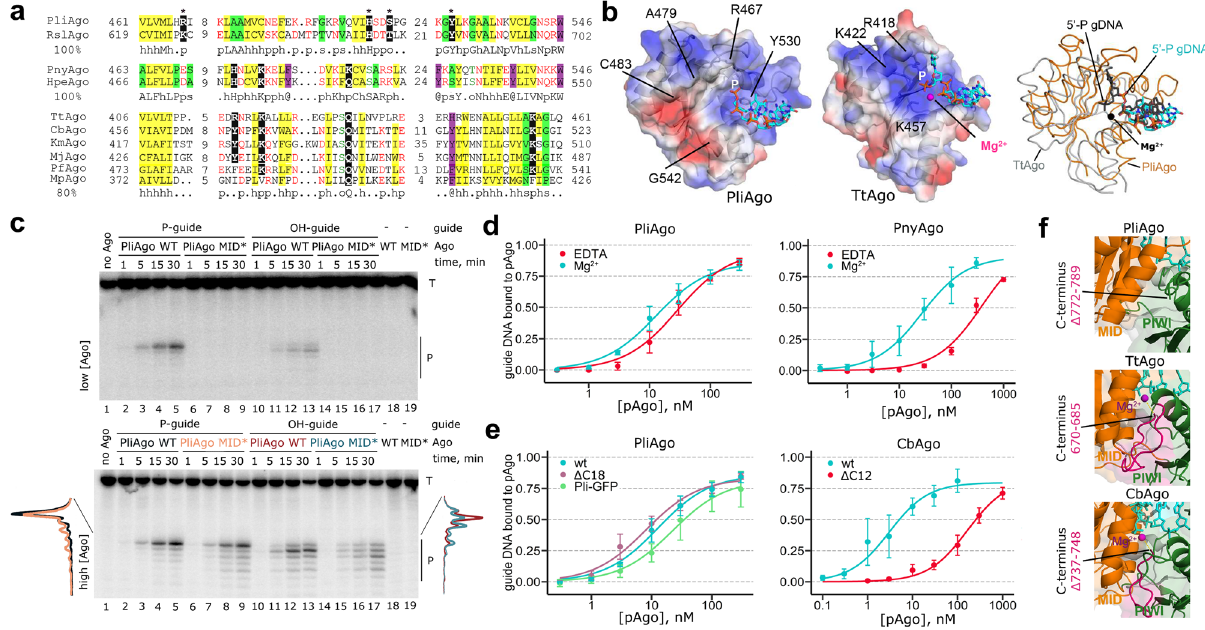
Fig. 3 | Role ofthe MID pocket in guide DNA binding and targetRNA cleavage. a Alignment of the MID pocket in various groups of pAgos. Conserved residues of the MID motif involved in 5 ’ -nucleotide interactions are indicated in black. MpAgo has a hydrophobic MID pocket and binds 5 ′ -hydroxylated guide RNAs but is more closely relatedto canonical pAgos thanto PliAgo.The consensus for each group is shown underneath the alignment: ‘ h ’ , hydrophobic residues (WFYMLIVACTH); ‘ p ’ , polar(EDKRNQHTS); ‘ s ’ ,small(ACDGNPSTV); ‘ o ’ ,OH-containing(ST); ‘ @ ‘ ,aromatic (YWFH). b Interactions of the MID domain with guide 5 ’ -end (stick) in PliAgo ( left ) and TtAgo (PDB: 3DLH 32 ) ( middle ). Electrostatic potentials are shown as surfaces (blue, basic; red, acidic; white, neutral). ( Right ) Overlay of the MID pockets of PliAgo/P-gDNA (MID, orange; DNA, cyan) and TtAgo/gDNA complexes (MID, gray; DNA and Mg 2+ , black). c Kinetics of RNA cleavage by wild-type and MID* PliAgo (R467A/Y530A) loaded with 5 ’ -P or 5 ’ -OH gDNA, at low (50nM) or high (500nM) PliAgo concentrations (representative gel from two independent experiments). Thereactionswereperformedwith5 ’ -P 32 -labeledtargetRNA;positionsofthetarget